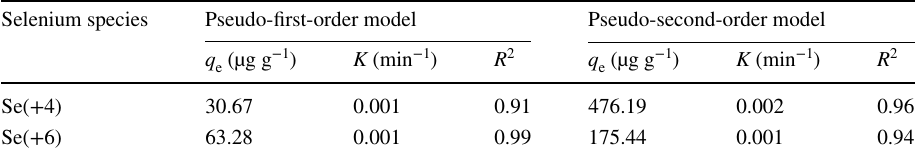
Table 2 Kinetics parameters for selenite and selenate adsorption onto MAA